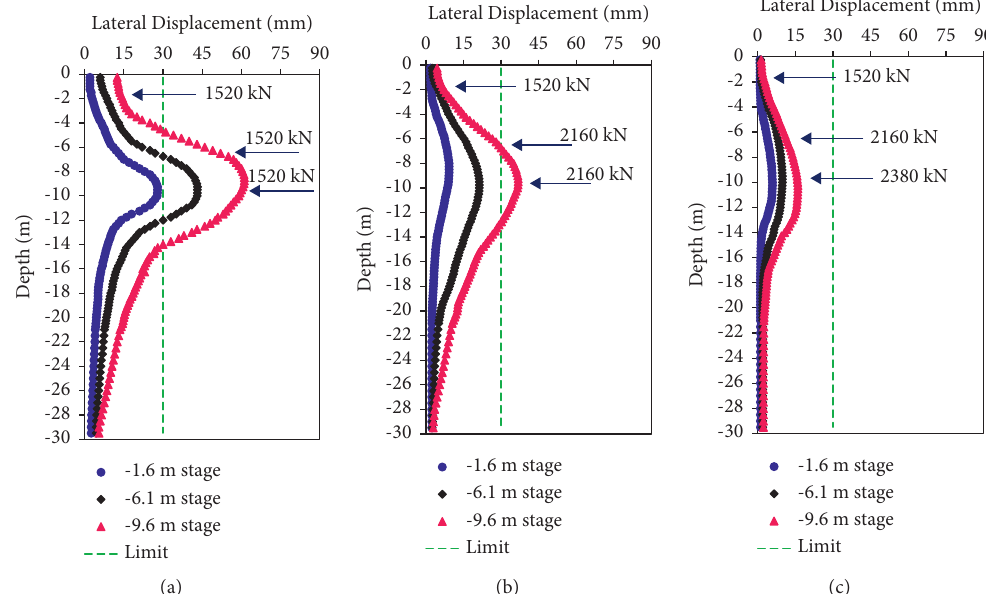
Figure 22: Influence of the application of steel and servo axial loading capacities on the profile of wall lateral displacement. (a) First case. (b) Second case. (c) Third